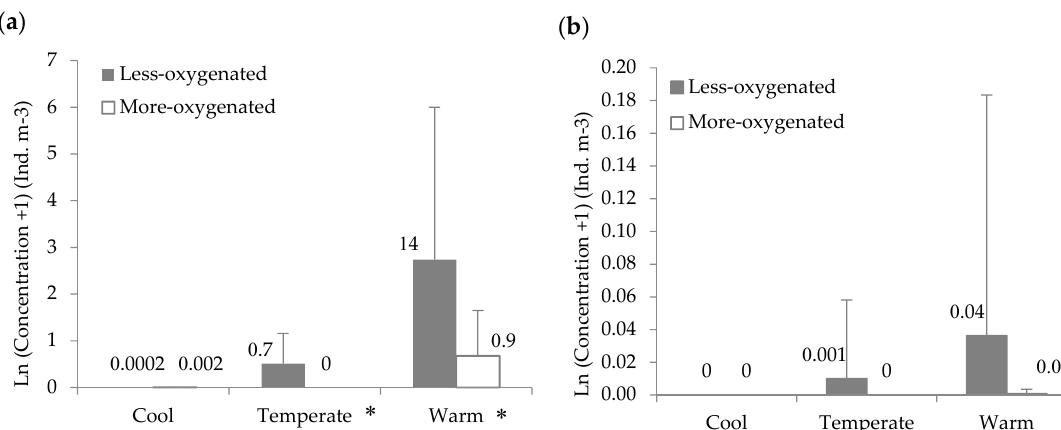
Figure 11. Comparison of ( a ) ctenophore ( Mnemiopsis leidyi) and ( b ) bay nettle ( Chrysaora chesapeakei ) concentrations between More-oxygenated (open bar) and Less-oxygenated (closed bar) subgroups within temperature groups (Cool, Temperate, Warm). Numbers indicate average concentrations, error bars indicate standard deviations, and * indicates significant differences in a Kruskal-Wallis test at α = 0.05. Table 4. The Kruskal-Wallis test on differences in concentrations of zooplankton and fish between the more-oxygenated (MO) and less-oxygenated (LO) subgroups within the cool (C), temp (T), and warm (W) groups.